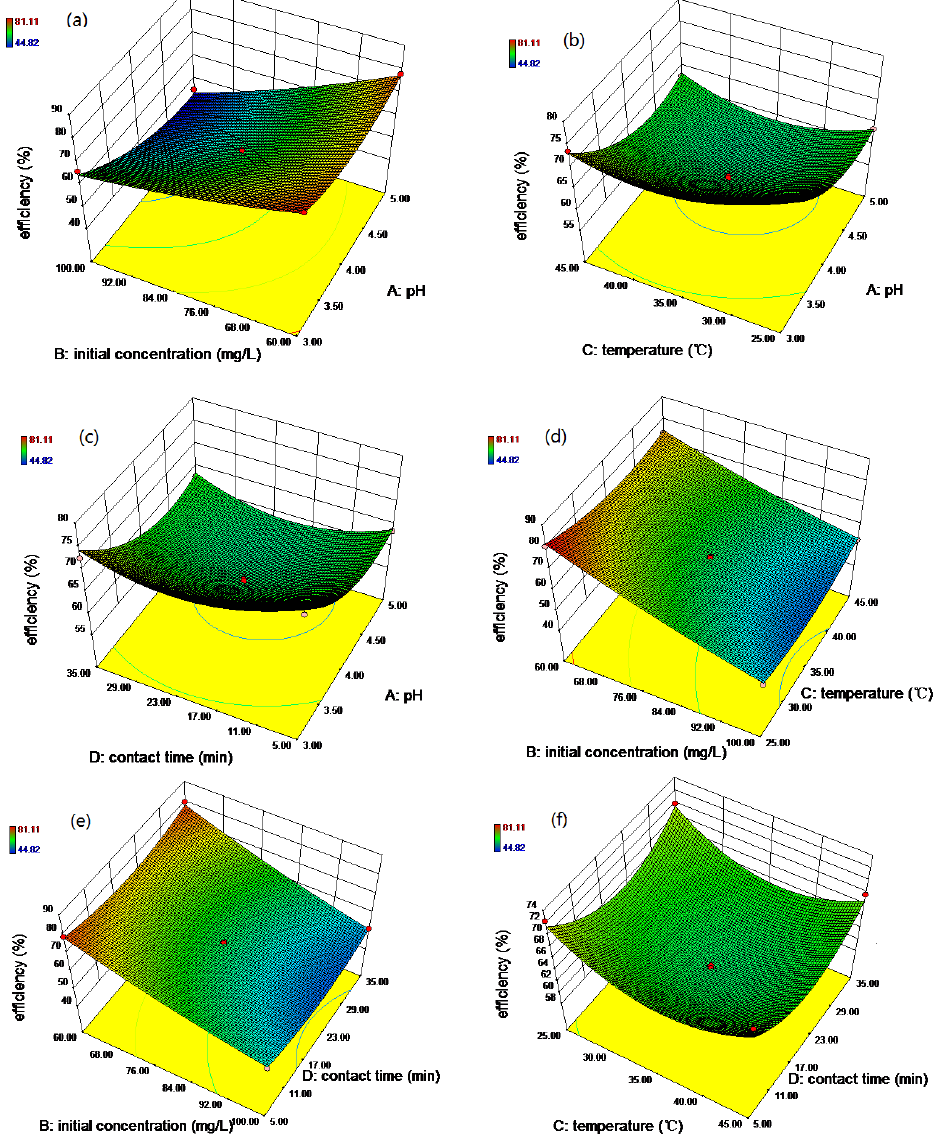
Figure 10. The 3D plots showing the effect of initial pH and initial concentration ( a ); initial pH and temperature ( b ); initial pH and contact time ( c ); initial concentration and temperature ( d ); initial concentration and contact time ( e ); and temperature and contact time ( f ) on the removal of Rh B.